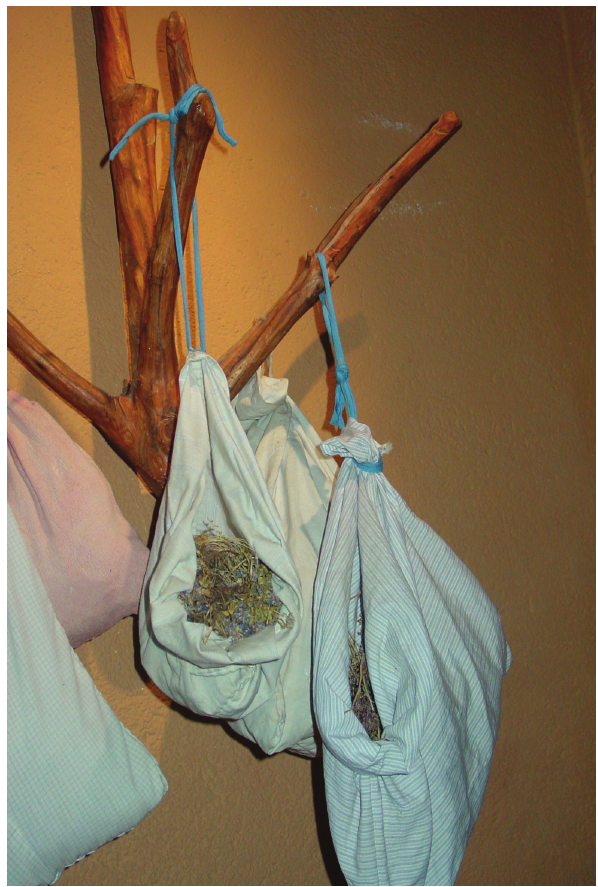
Figure 2: Coixineres . Bags made from old bed linen © Museu de les Trementinaires, Tuixent, Lleida, Spain.